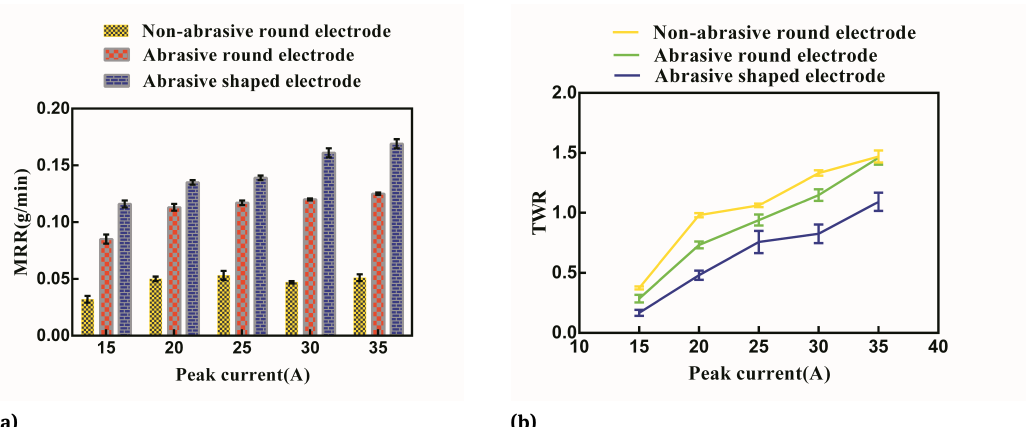
Figure 8: Influence of peak current on MRR and TWR (applied voltage = 120 V, pulse duration = 120 µ s, duty cycle = 1:5, rotary speed = 2400